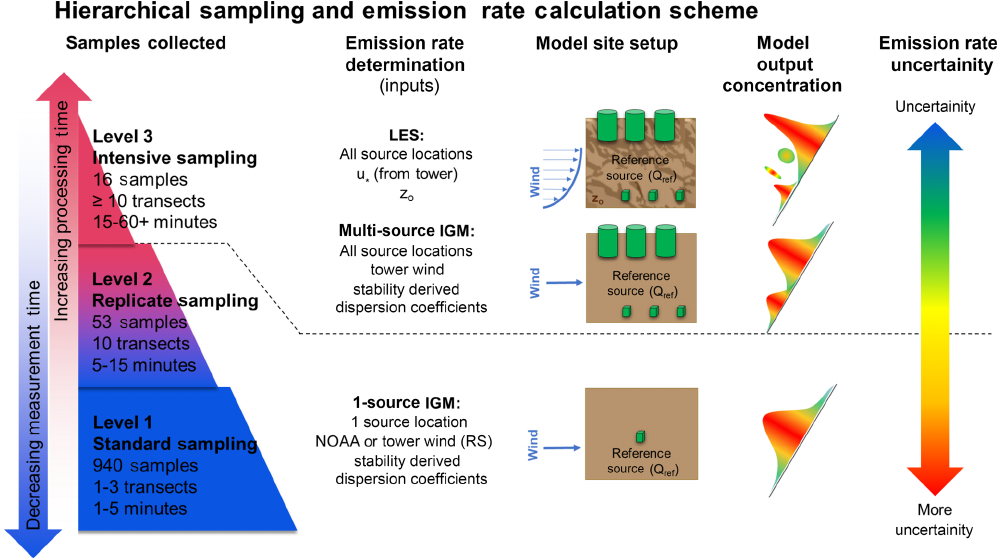
Figure 6. Finalized sampling and emission rate calculation strategy employed in this study showing actual measurements with increasing complexity and decreasing sample size as well as models with increasing complexity and decreasing uncertainty. The second column denotes user inputs needed for each pathway, with different pathways needing more or less inputs and different types of inputs. For instance, the stability-derived dispersion coefficients are necessary for level 1 and 2, but not level 3. In this schematic u ∗ is friction velocity and z o is terrain roughness length. The dashed lines denote the pathways data typically followed. Standard and replicate sampling always went through a single-source (1-source) IGM pathway. Note that the 1-source IGM can also be calculated for intensive samples as is shown for comparison purposes in this work. Abbreviations: LES (large eddy simulation), IGM (inverse Gaussian